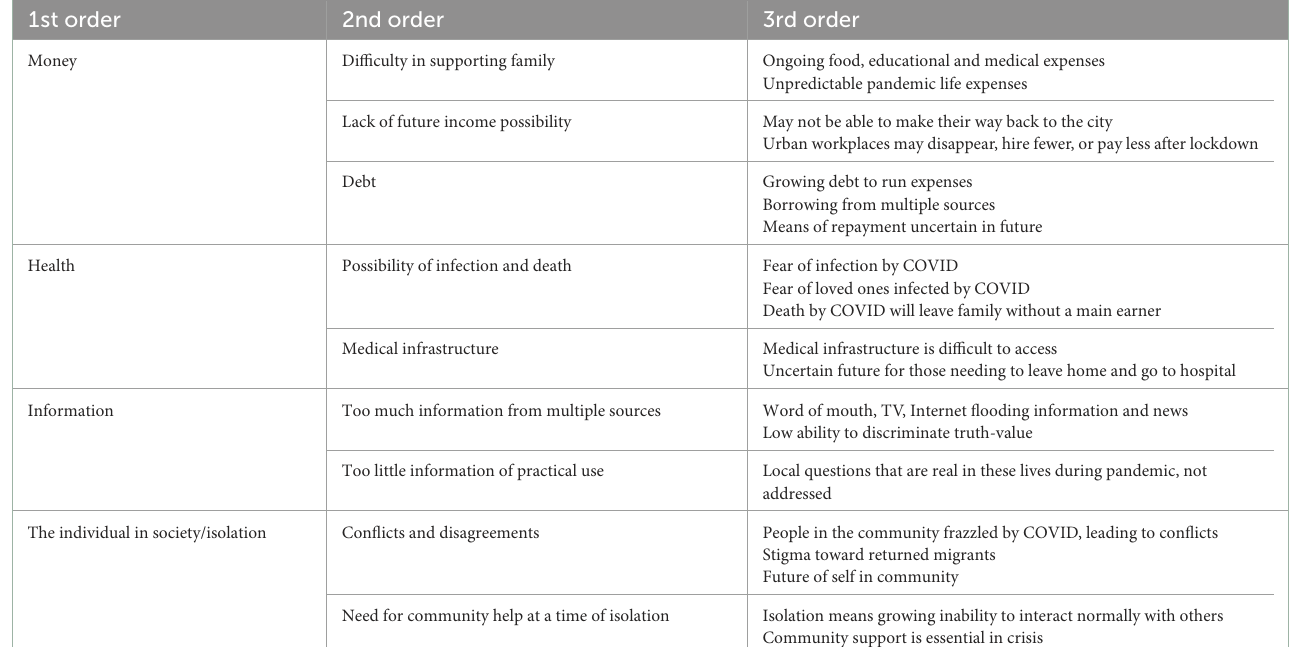
TABLE 3 Evolution of typology, step